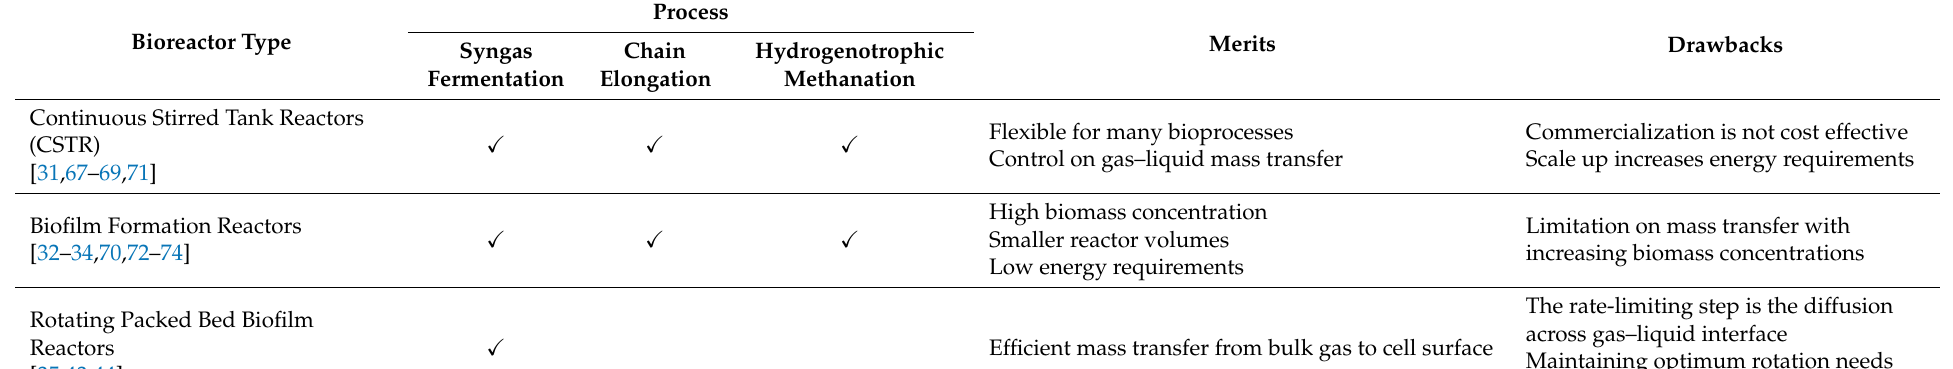
Table 1. Merits and drawbacks of different bioreactor configurations used for C1 gas